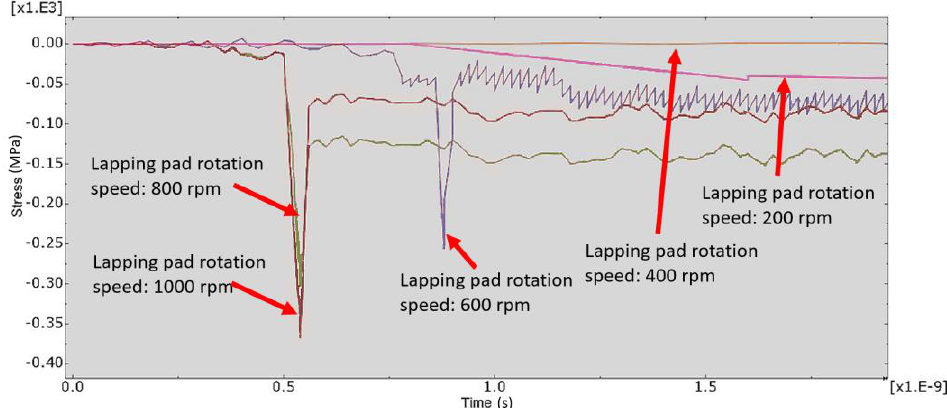
Figure 6. Two surfaces ( a and c ) with tool marks lapped under different rotational speed. The sur- face ( b ) had almost no change at a rotational speed of 500 rpm. The surface ( d ) started to show pits and scratches at a rotational speed of 1500 rpm [1].